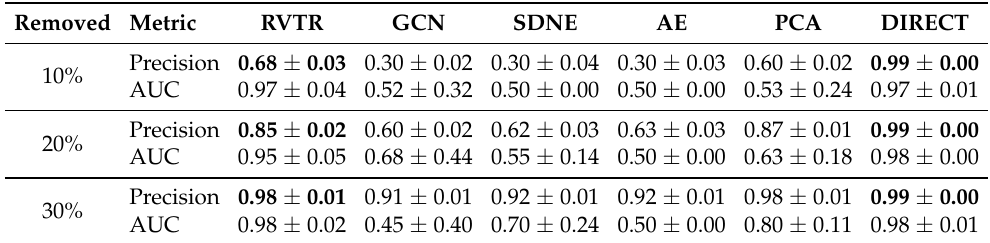
Table 3. The prediction results by different methods tested on the network of 2000. The tests were performed on 10%, 20% and 30% nodes removed, respectively.